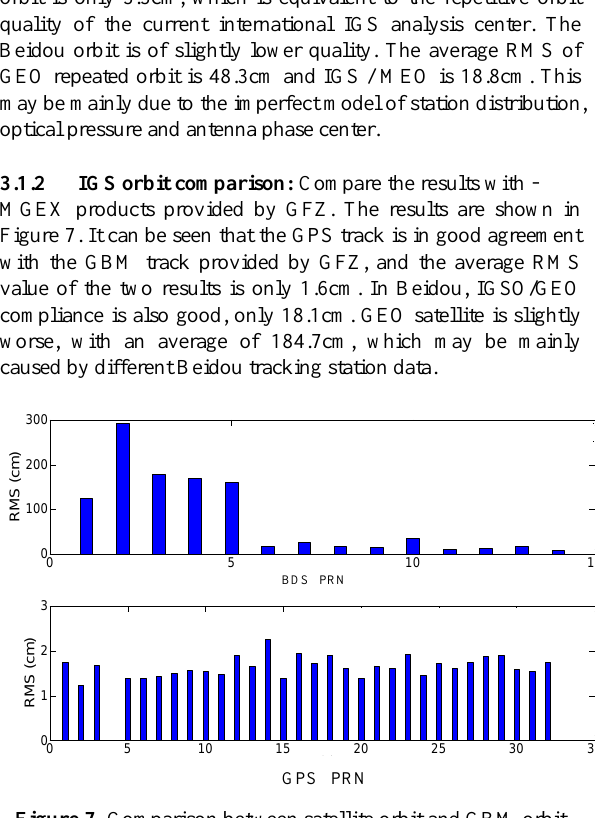
Figure 7 . Comparison between satellite orbit and GBM orbit products released by GFZ.